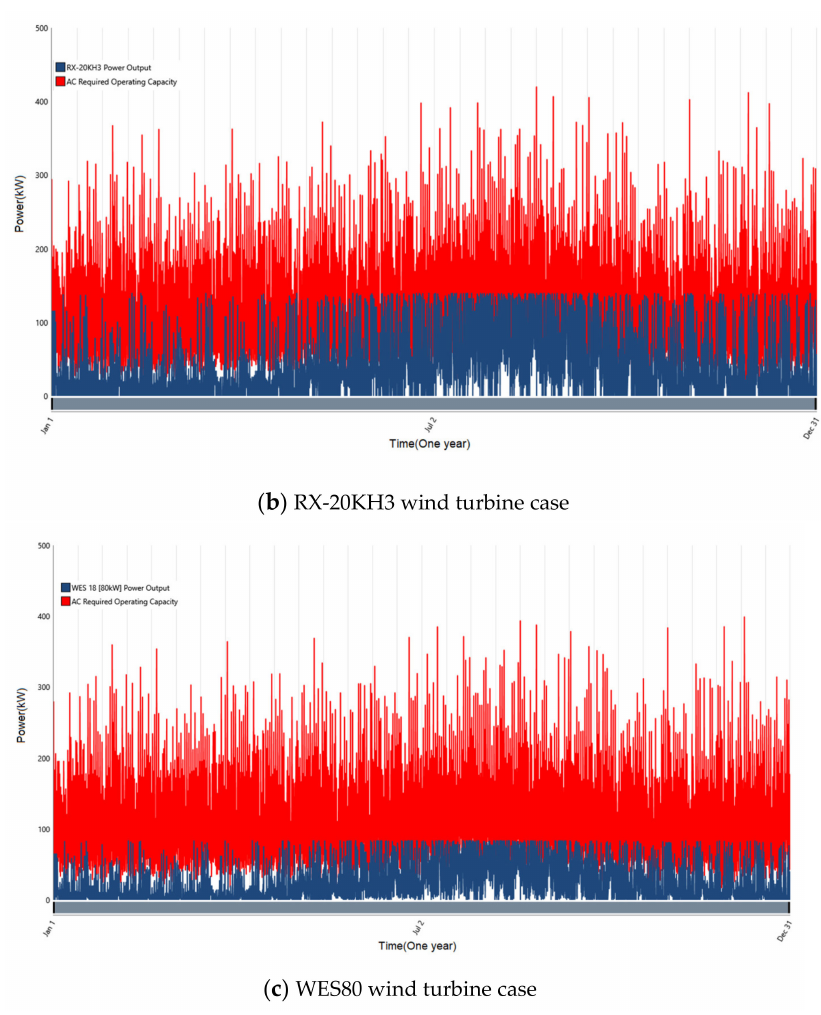
Figure 18. Yearly required power and wind farm penetration in